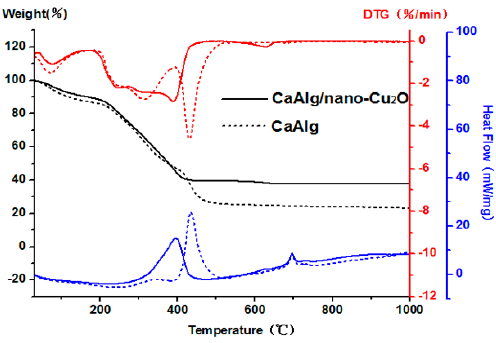
/ nano-Cu 2 O under N 2